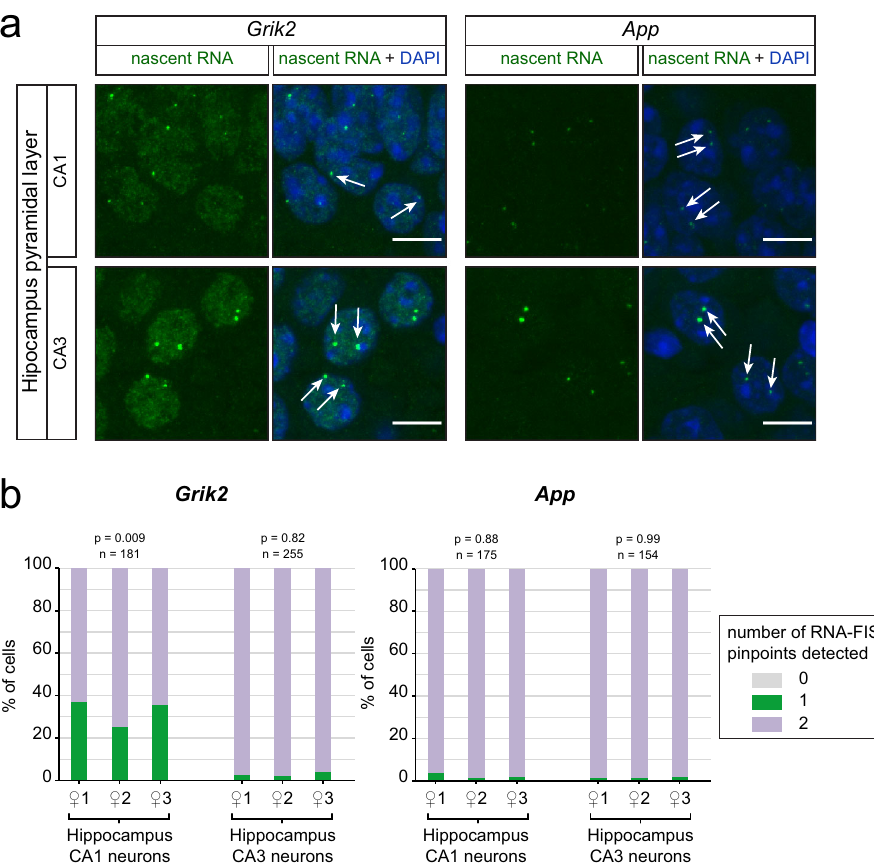
Fig. 6 Monoallelic expression is cell-type speci fi c in vivo. a Z-stack of confocal images showing representative cells with nascent RNA-FISH signals for Grik2 and App , in hippocampal sections of adult inbred mice. Scale bar 10 µ m. b Quanti fi cation of nascent RNA-FISH in pyramidal neurons of CA1 and CA3, in the three female inbred mice analysed. Chi-squared test (see Methods); n is the number of cells analysed for each gene and each